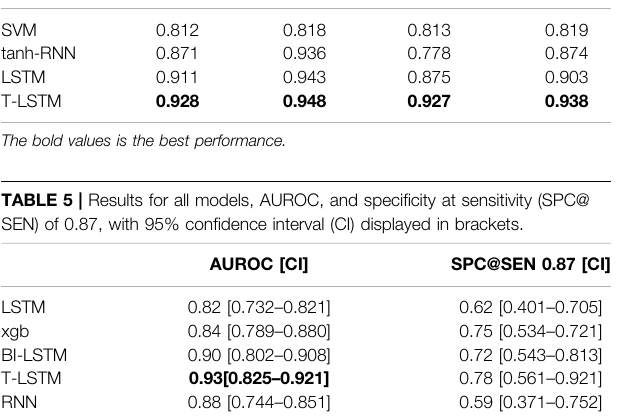
TABLE 4 | Comparison of prediction performance of different methods. Algorithm